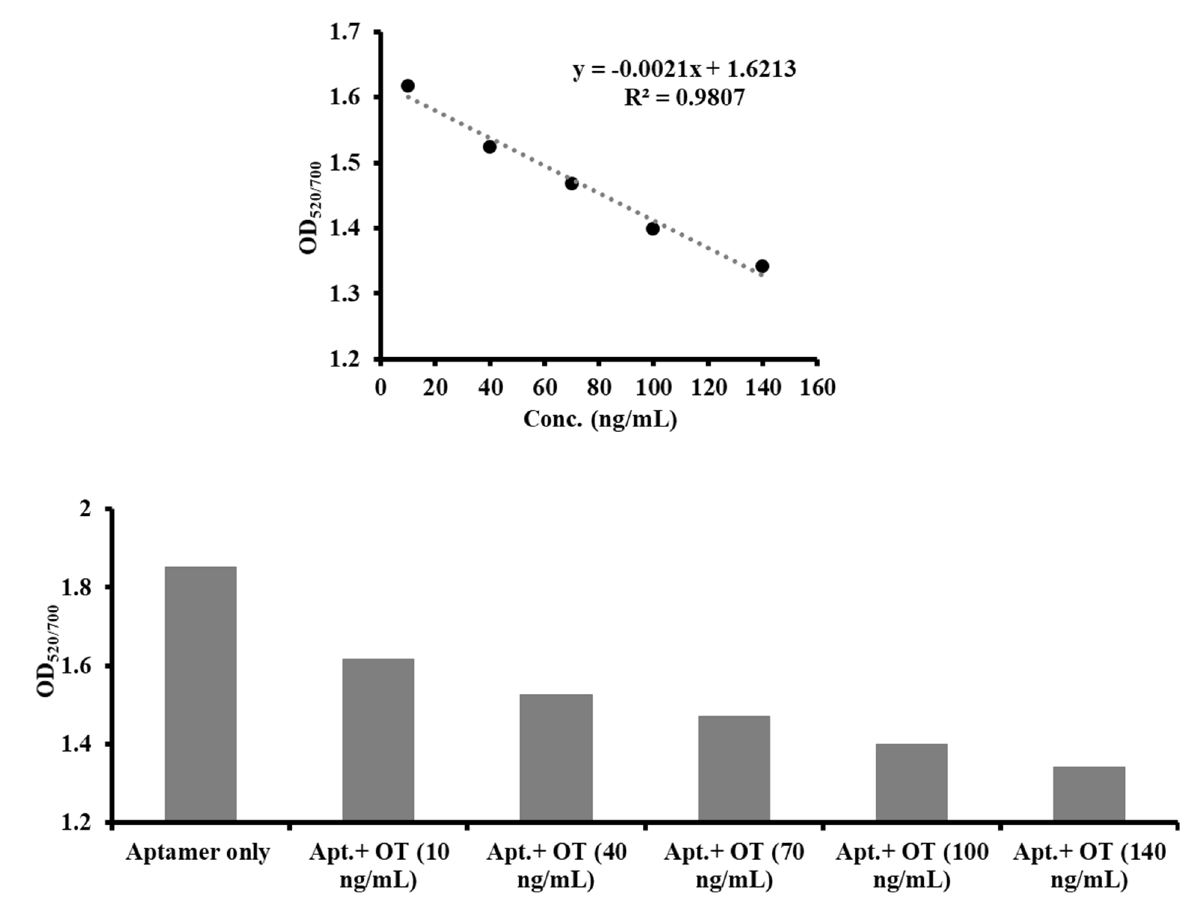
Figure A3. Sensitivity analysis of the colorimetric assay. Top: Linear regression produced a calibration curve with an R 2 value of 0.9807. Bottom: Dose-dependent results were observed from the AuNP assay in the buffer.